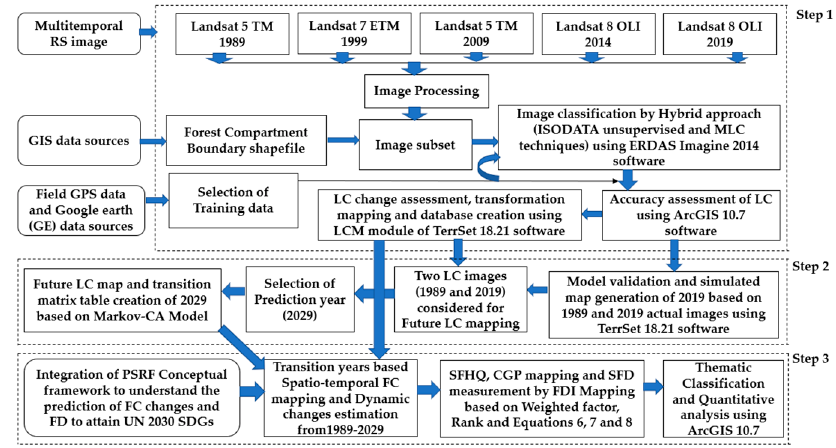
Figure 4. A methodological flowchart model used in this study. Note: RS, remote sensing; TM, thematic mapper; ETM, enhanced thematic mapper; OLI, operation land imager; GIS, geographical information system; GPS, global positioning system; ISODATA, iterative self-organizing data analysis techniques; MLC, maximum likelihood classifier; LC, land cover; Markov-CA, Markov cellular automata; LCM, land change modeler; PSRF, pressure–state–response–future; FC, forest cover; FD, forest degradation; UN, United Nations; SDGs, sustainable development goals; SFHQ, spatial forest health quality; CGP, constant good patch; SFD, spatial forest degradation; FDI, forest degradation